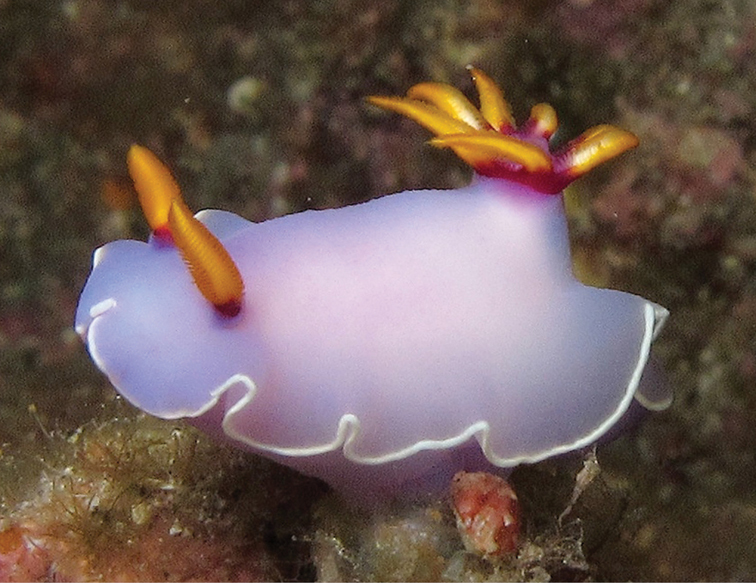
Risbecia bullockii, 35 mm, La Réunion, H Flodrops.